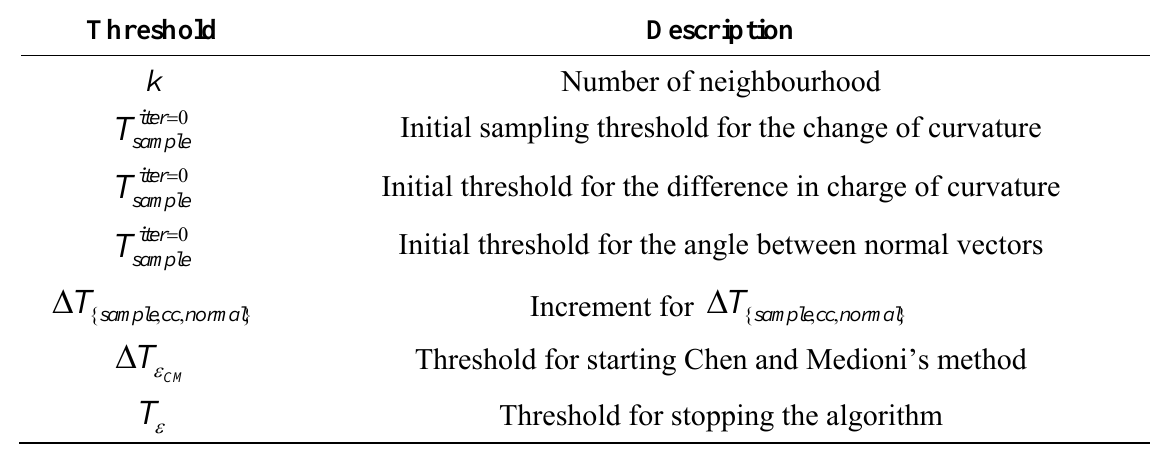
Table 1. Threshold values are used in the